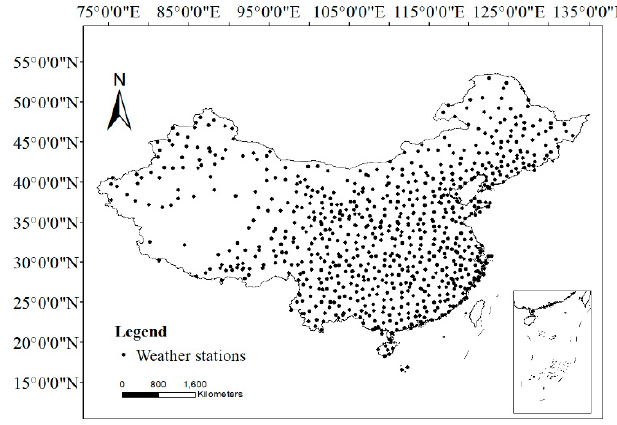
Figure 1. Spatial distribution of weather stations in China.